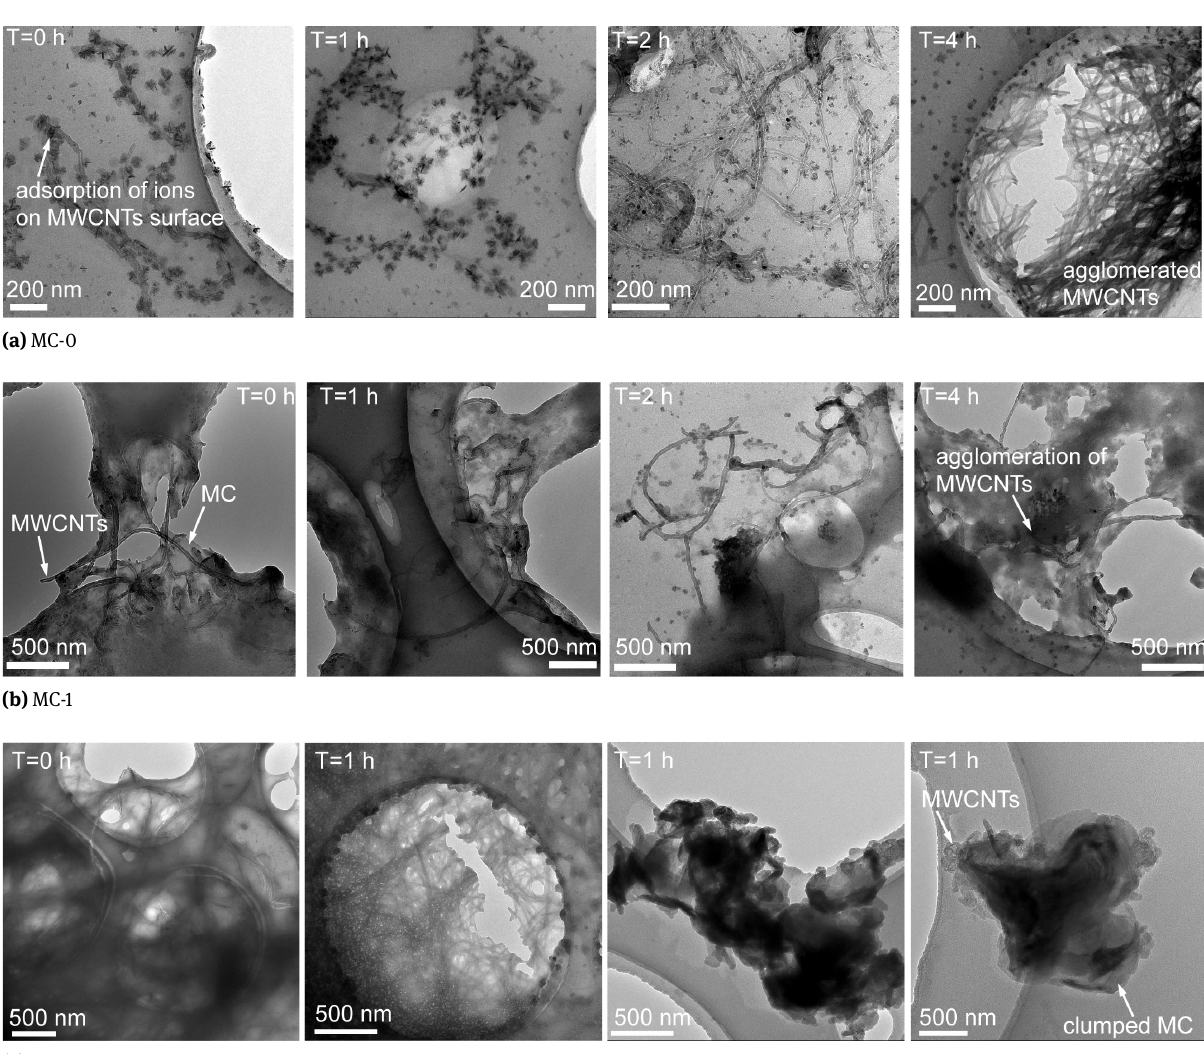
Figure 5: TEM images of MWCNTs agglomerates in pore solution at different time